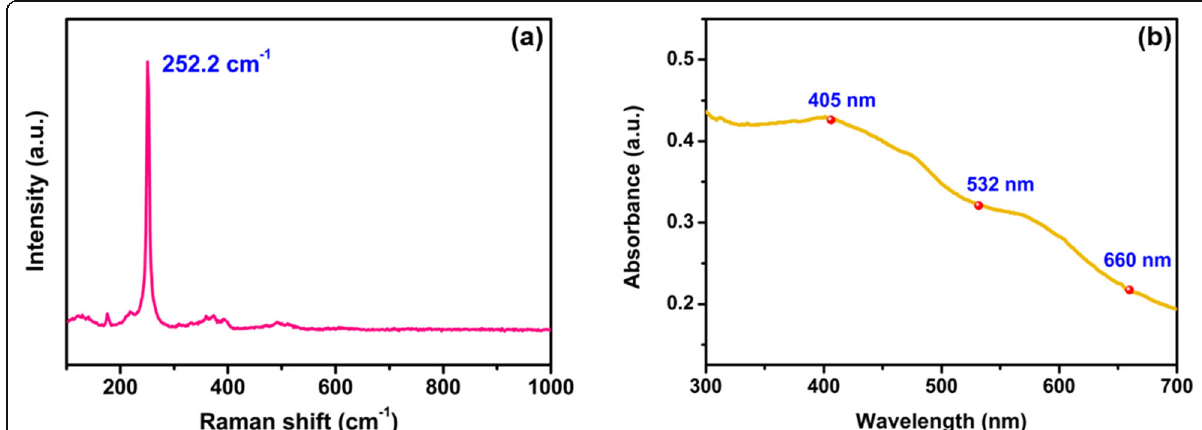
Fig. 1 a Raman spectrum of WSe 2 . b Absorption spectrum of WSe 2